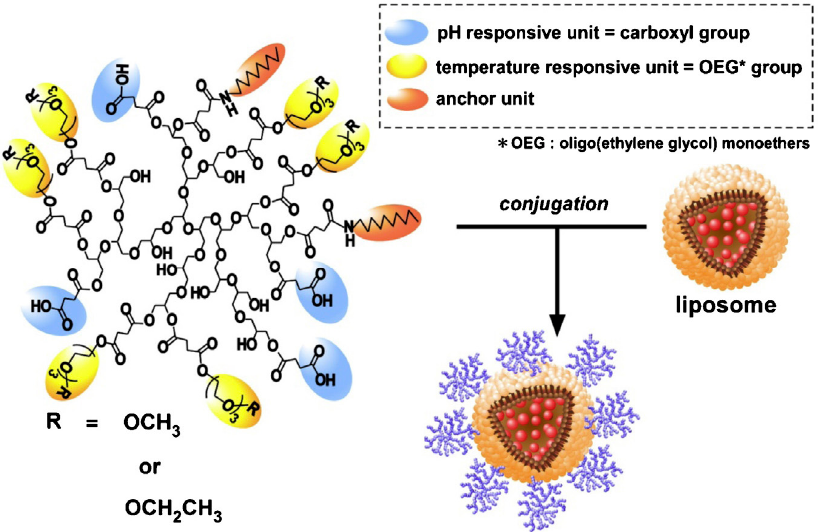
Figure 9. Design of temperature and pH dual-stimuli-responsive liposomes using hyperbranched poly(glycidol)s with temperature-sensitive OEG groups and pH-sensitive succinyl groups. Repro- duced with permission from [112] . Copyright © 2014 Elsevier.